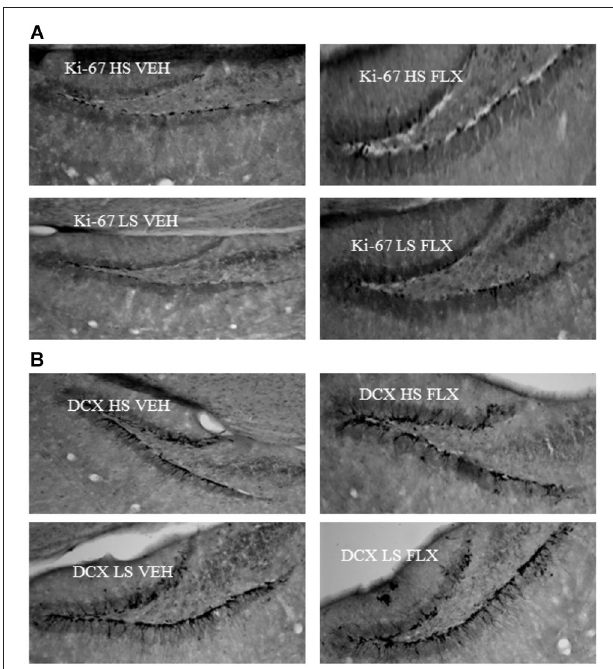
FIGURE 6 | Representative pictures of ki67 (6A) and DCX (6B) labeling in the dentate gyrus of the hippocampus . HS: High suppressers, LS: Low suppressers, VEH: vehicle, FLX: